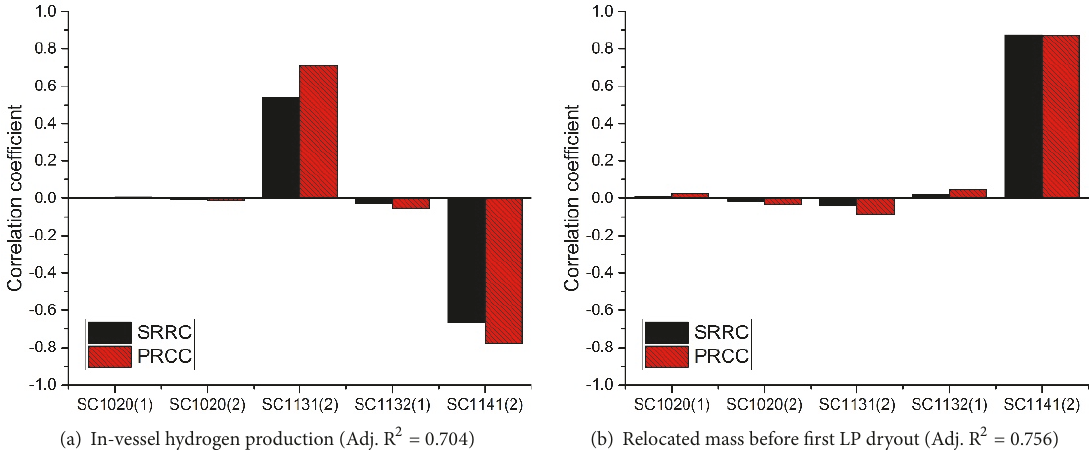
Figure 11: Linear regression results of potential factor about first LP dryout